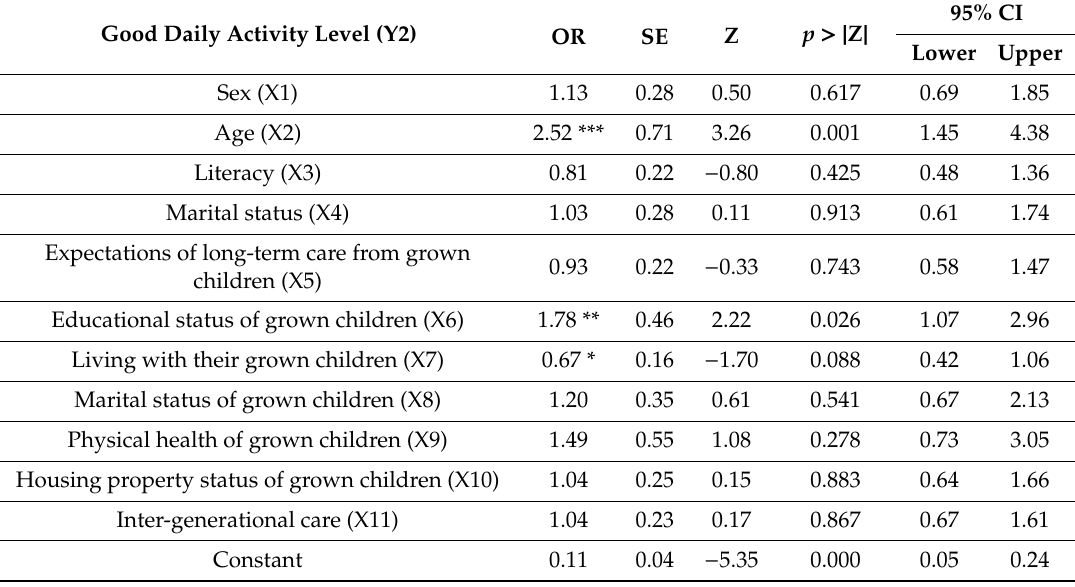
Table 6. Logistic regression results of daily